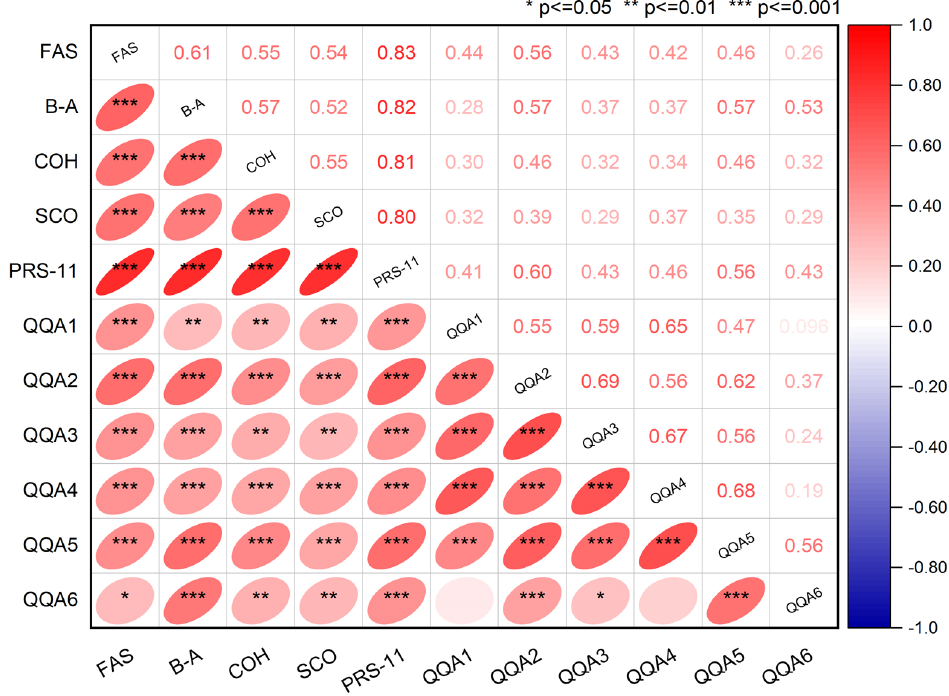
Figure 7: Pearson correlation matrix of the Perceived Restorativeness Scale (PRS-11), its components: Fascination (FAS); Being-Away (B-A); Coherence (COH) and Scope (SCO) and the Qualitative Aspects